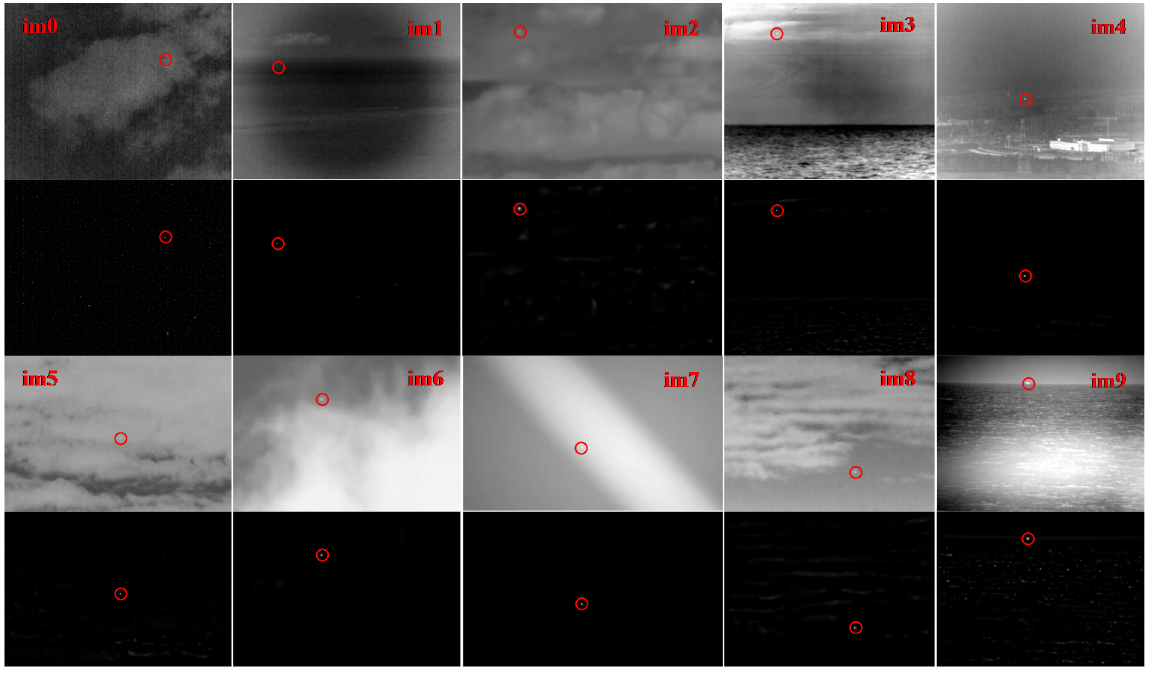
Figure 4. Enhancement results of the proposed method on representative images (im0–im9) in SIRST dataset.